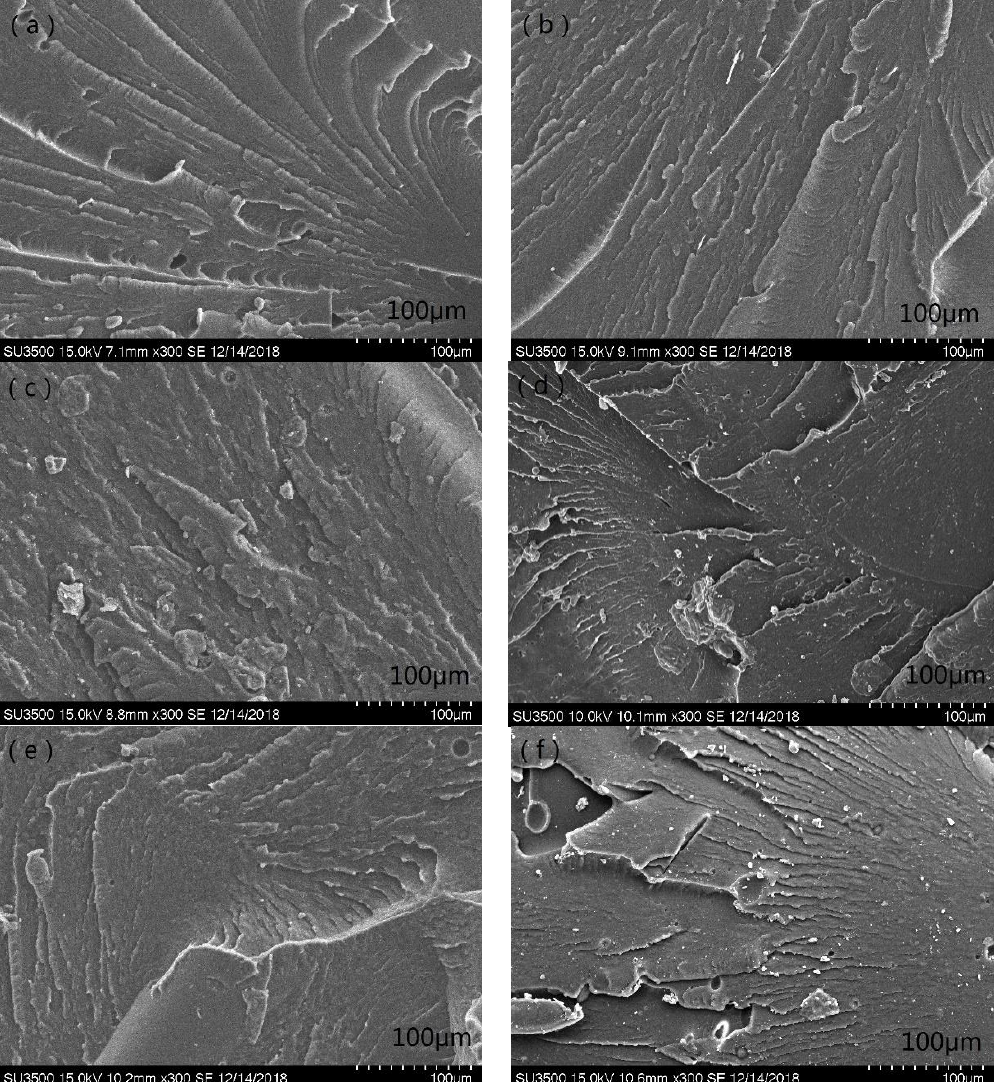
Figure 7. X-direction ( a ), y -direction ( c ), and z -direction ( e ) test samples printed from filament made of fresh pellets; x -direction ( b ), y -direction ( d ), and z -direction ( f ) test samples printed from filament made of recycled powder.